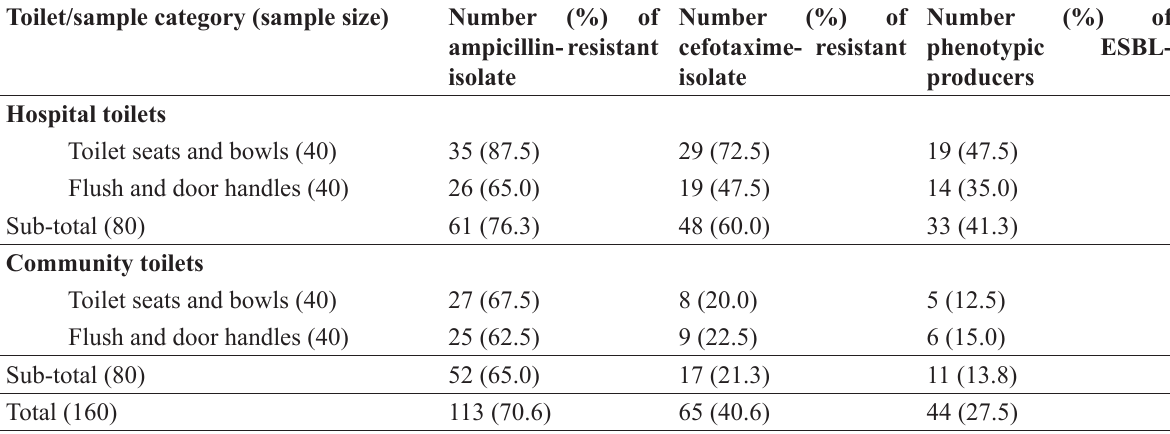
Table 1: Phenotypic detection of extended spectrum β-lactamase producing bacteria in public toilets in Abeokuta, Nigeria. Toilet/sample category (sample size)